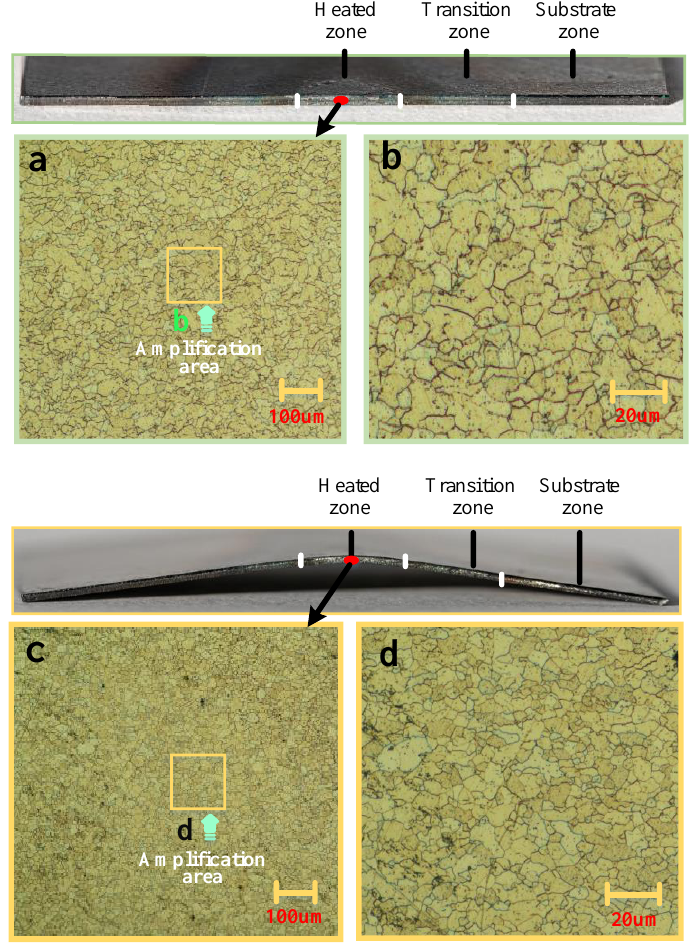
Figure 13. Comparison of grain size between the two methods: ( a ) ×100 time (traditional method), ( b ) ×500 time (traditional method), ( c ) ×100 time (BPM) and ( d ) ×500 time (BPM).